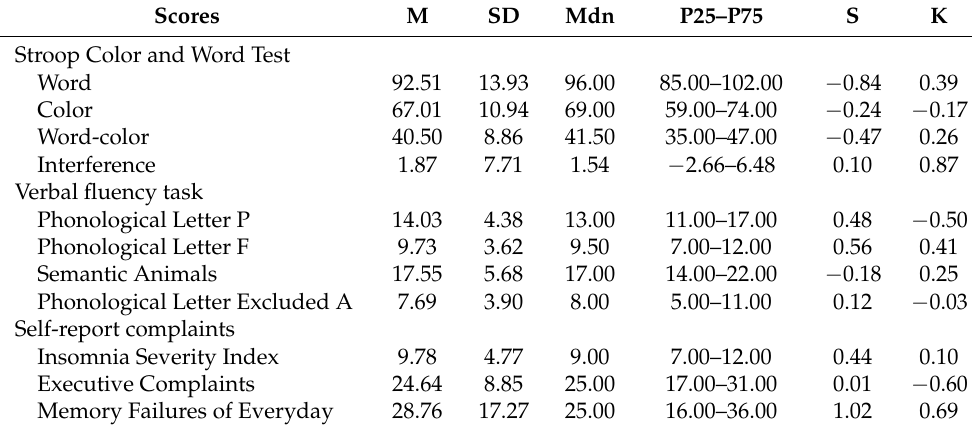
Table 4. Postpartum women’s performance in the Stroop Color and Word Test, Verbal Fluency Tasks, and self-report complaints ( n =